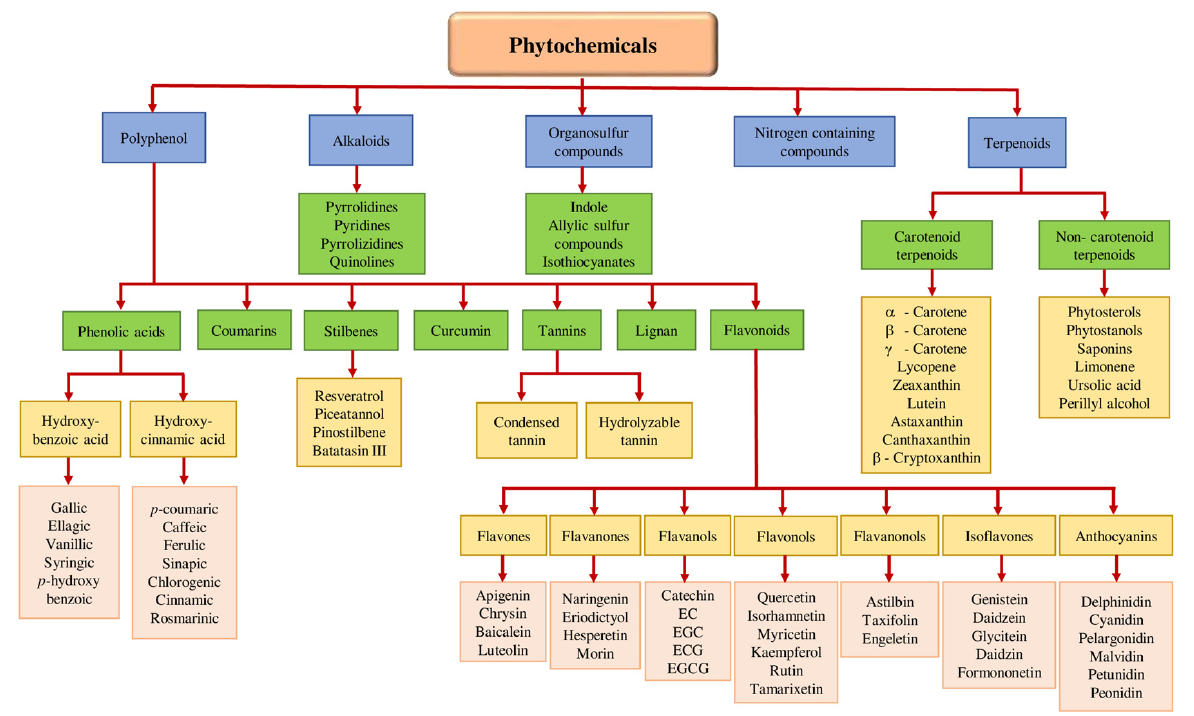
Figure 1. Classification of Dietary Phytochemicals (self-generated) [EC: epicatechin; EGC: epigallo- catechin; ECG: epicatechin gallate; EGCG: epigallocatechin 3 ‐ gallate].